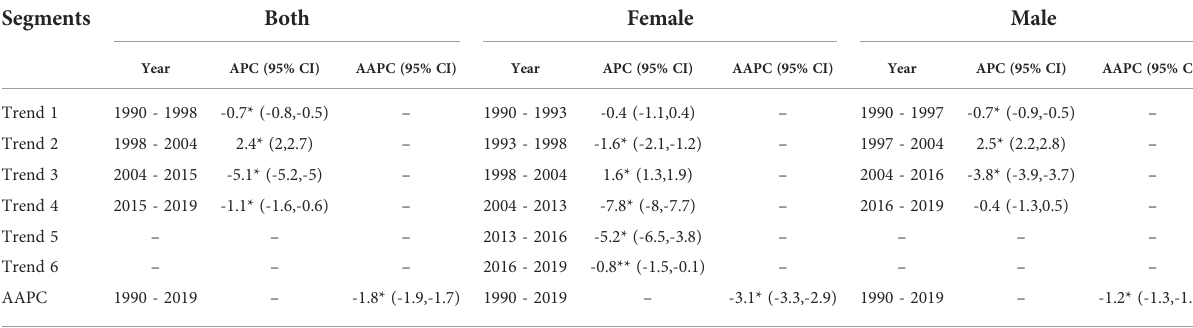
TABLE 2 Joinpoint analysis of trends in age-standardized mortality rates (ASMR) of esophageal cancer in China, 1990 – 2019. Segments